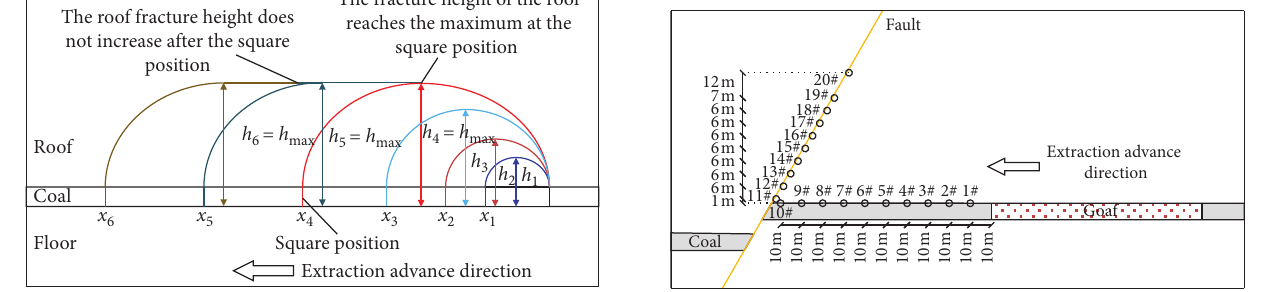
Figure 6: Layout of stress measuring i is the